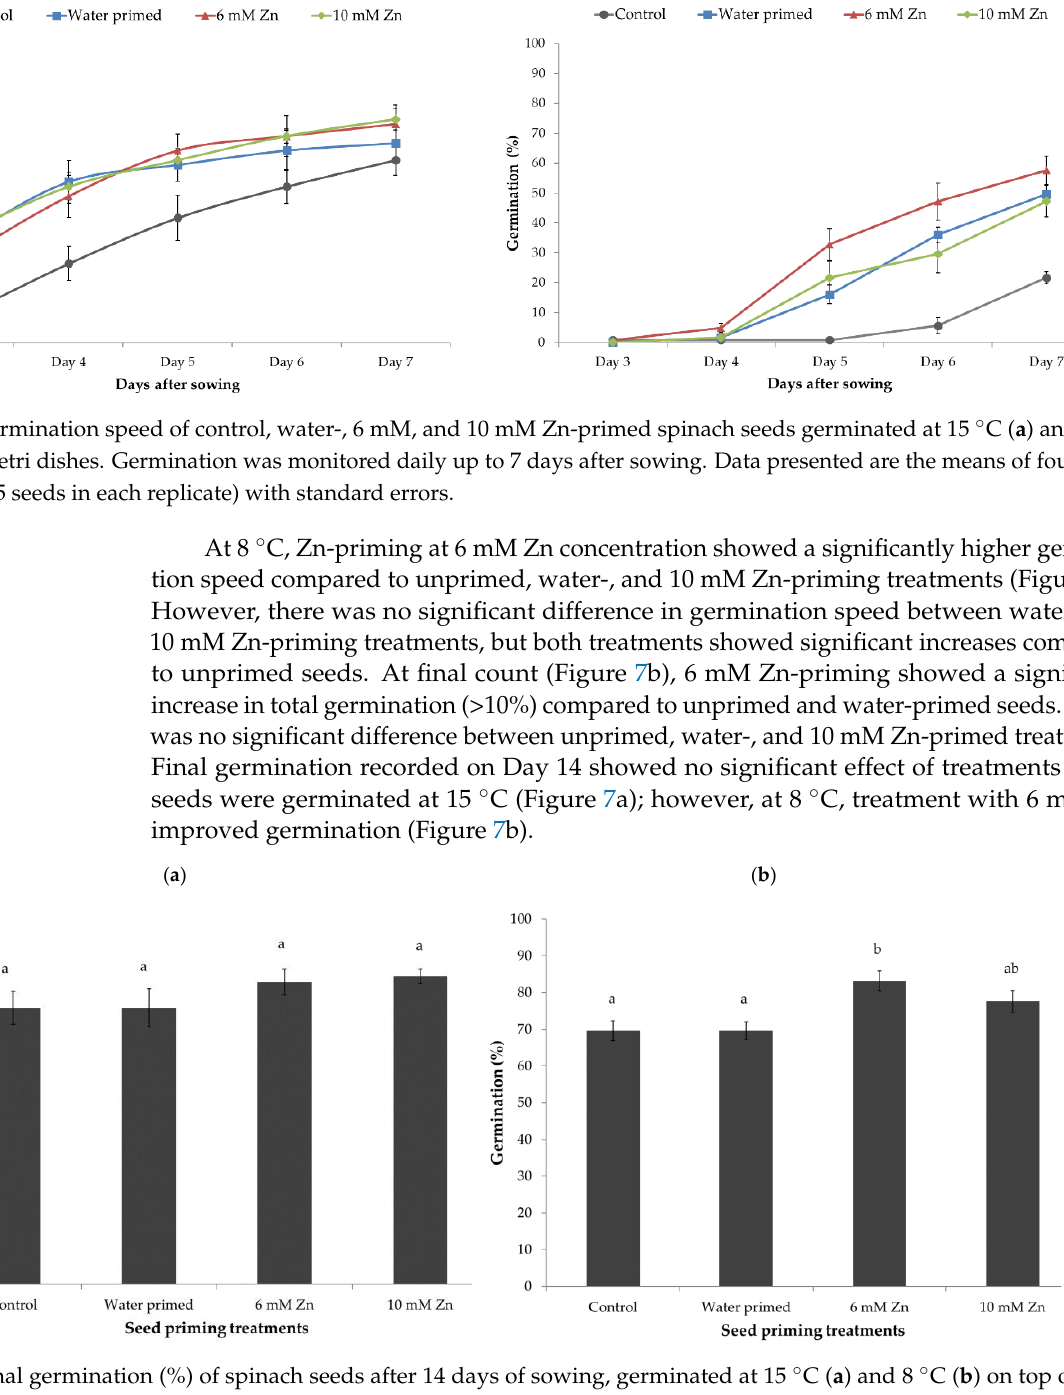
Figure 7. Final germination (%) of spinach seeds after 14 days of sowing, germinated at 15 °C ( a ) and 8 °C ( b ) on top of paper in Petri dishes. Seed priming treatments include control (unprimed), water- primed, 6 mM, and 10 mM Zn in the priming solution. Bars represent the mean and standard error (SE) of four replicates (25 seeds in each replicate). Significant differences between the means were calculated at p < 0.05 and marked with different alphabets.